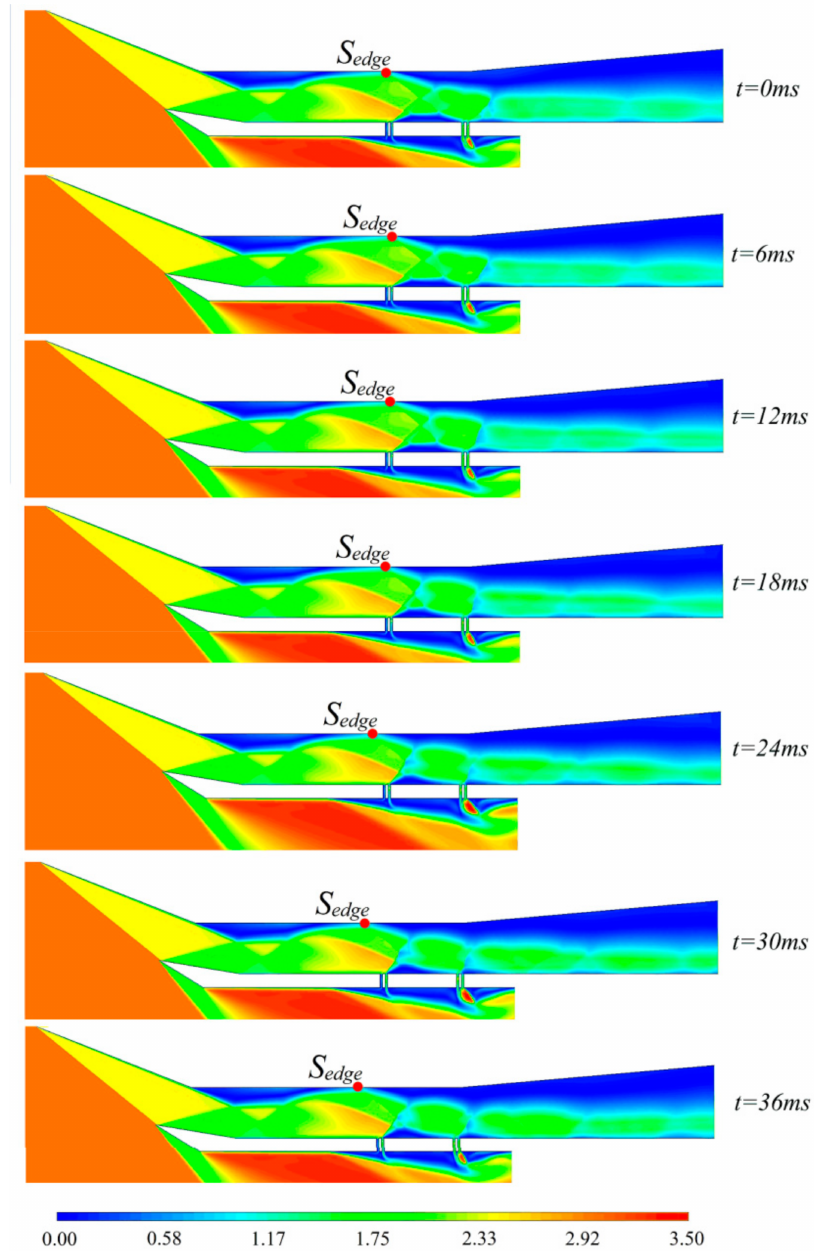
Figure 18. Mach number change process of Model